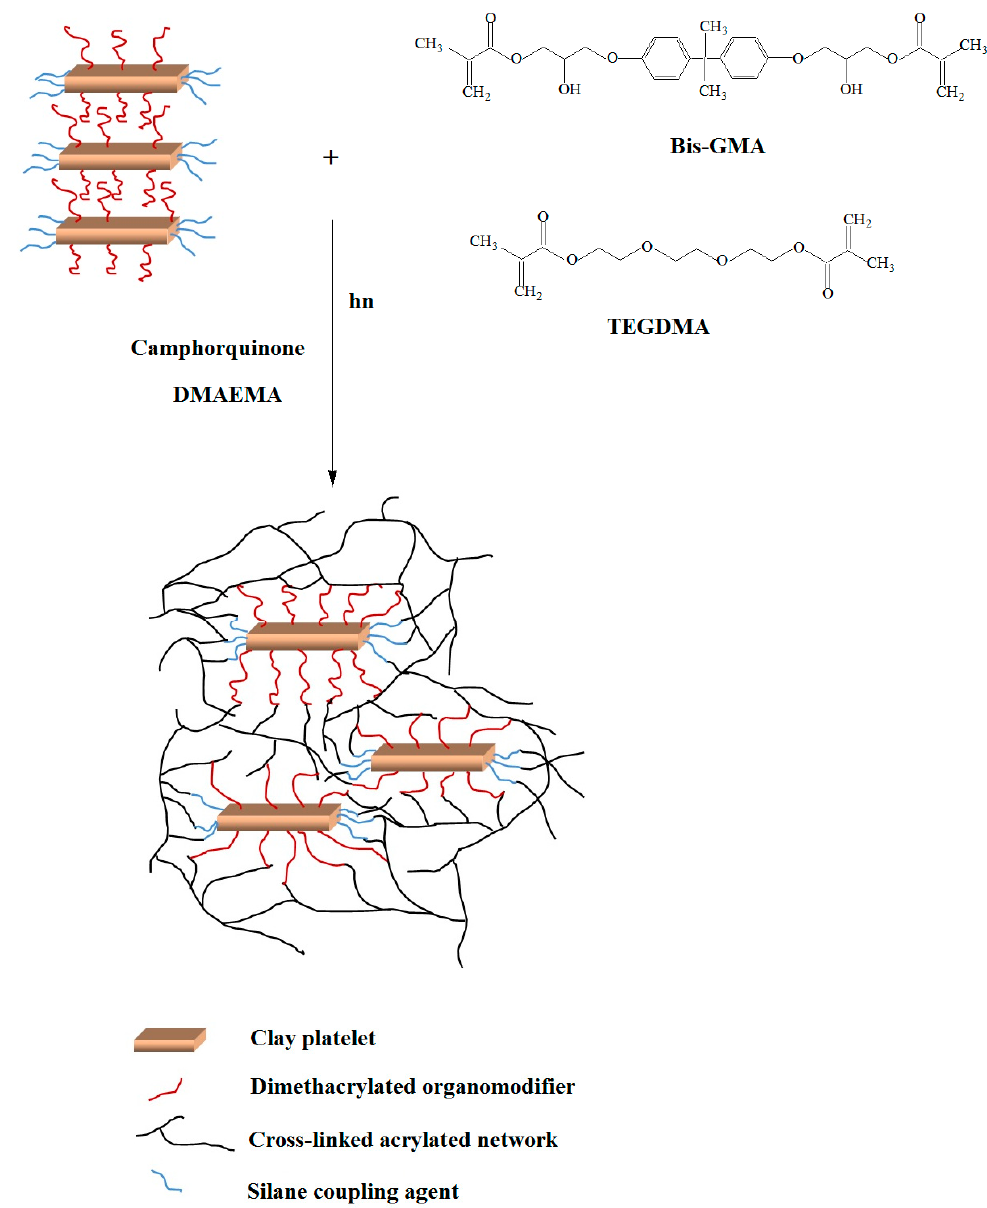
Figure 3. Schematic representation of nanocomposite formation indicating the possible chemical interactions between nanoclayorganomodifier and dental resin monomers.